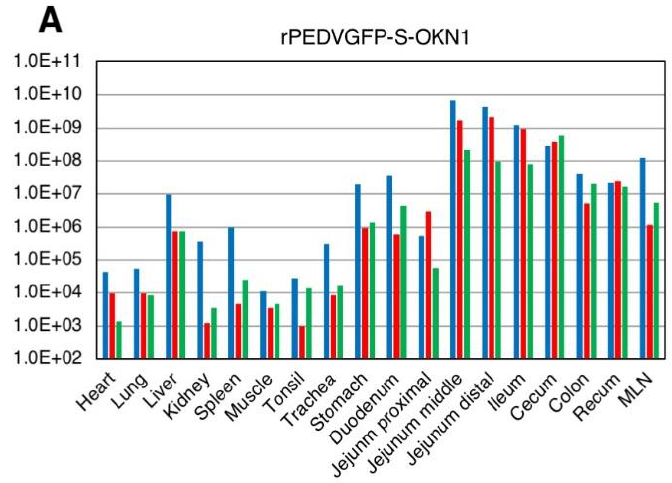
Figure 4. Virus shedding in feces ( A , B ) and sera ( C , D ) from piglets inoculated with the S-chimeric strain, rPEDVGFP-S-OKN1 ( A , C ), the S1-chimeric strain, rPEDVGFP-S1-OKN1 ( B , D ). Data are genome equivalents/mL in individual animals indicated in different colors as quantified at each time point by a real-time reverse-transcription quantitative PCR for the N gene. Three piglets from each group were euthanized at two days post-infection. The symbols (†) in graph mean death of individual piglets during observation period.